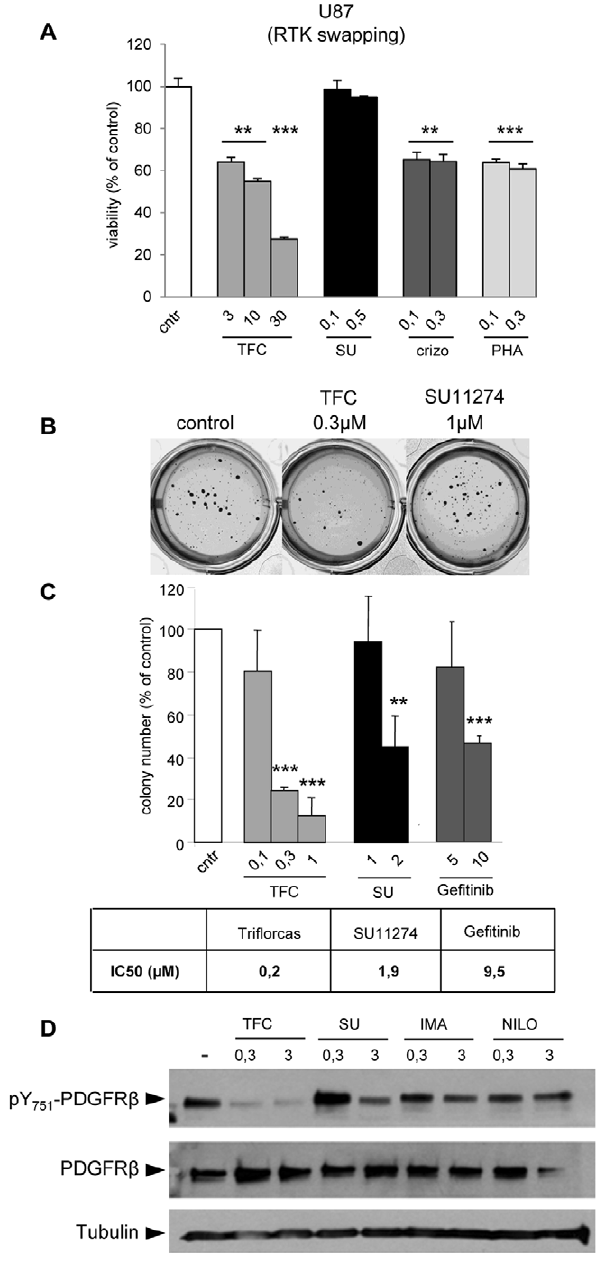
Figure 8. Triflorcas impairs survival and in vitro tumorigenesis of cancer cells resistant to single RTK inhibition through RTK swapping by also interfering with PDGFR b phosphorylation. (A) Survival of U87 cells was reduced by Triflorcas in a dose dependent manner ( m M; n=2). SU11274 (SU), crizotinib (crizo), and PHA665752 (PHA) were used at the indicated concentrations ( m M). (B and C) Triflorcas (TFC) impaired anchorage-independent growth of U87 cells, in a dose dependent manner ( m M; n=3). Gefitinib and SU11274 were used to inhibit ErbB1 and Met, respectively. (D) PDGFR b phosphorylation in U87 cells was drastically reduced in presence of Triflorcas. For western blot analyses, cells were cultured in presence or absence of Triflorcas, SU11274 (SU), Imatinib (IMA), or Nilotinib (Nilo) (0.3–3 m M). Total cell lysates were analyzed using anti-phospho-Y 751 -PDGFR b (pY 751 -PDGFR b ) (upper panel), anti-PDGFR b (middle panel), or Tubulin (bottom panel). Values are expressed as means 6 s.e.m. **P , 0.01; ***P , 0.001; Student- t